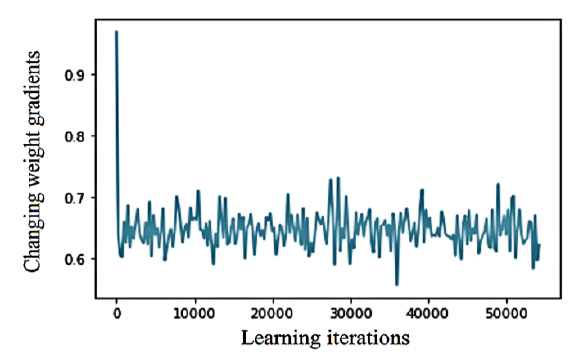
Fig. 1. Graph of uniform changes in the gradients of weights of an artificial neural network.